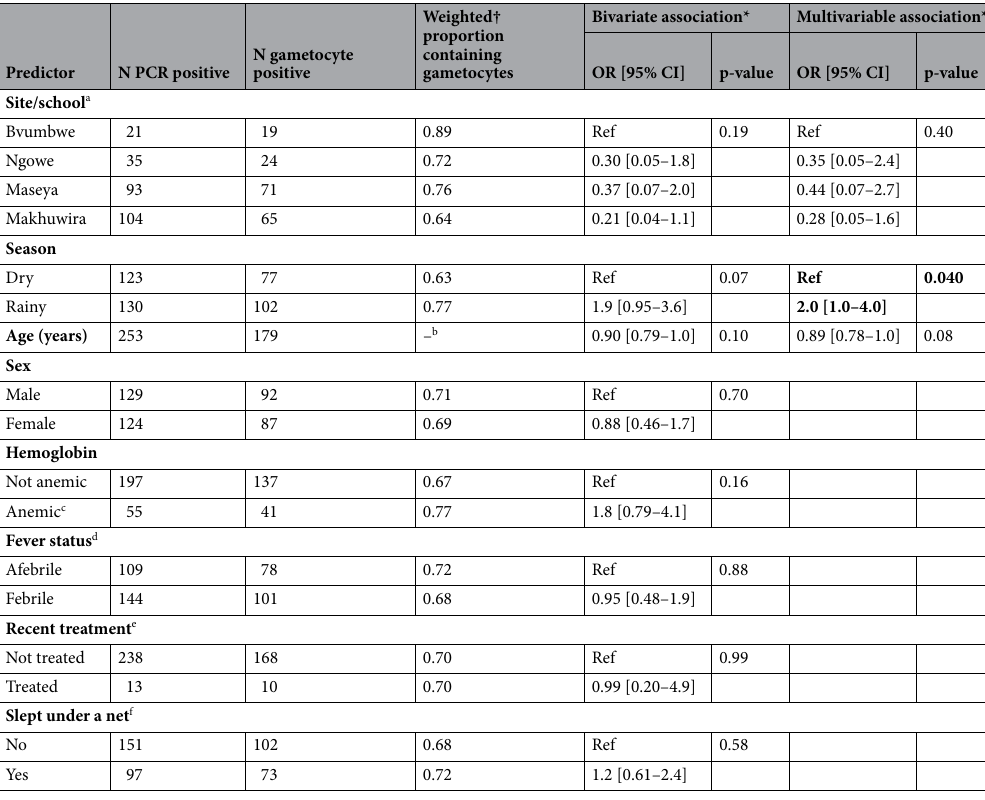
Table 1. Baseline prevalence and predictors of infections containing gametocytes among students with P. falciparum infections in the school-based cohort. † Survey weights were calculated for each stratum, defined as each grade within each school (details in Supplemental Information). * Obtained in a survey weighted logistic regression that analyzed the variables shown in the table. OR = Odds Ratio; CI = Confidence Interval. Bold values are statistically significant for p-values < 0.05. a Univariate association for school, all other associations include school. Prevalence setting: Bvumbwe-low, seasonal; Ngowe-moderate, seasonal; Maseya-high; Makhuwira-high. b Mean age of students with infections containing gametocytes was 10.9 years compared to 11.6 years among those whose infections did not contain gametocytes. c Hemoglobin < 11.0 g/dL; 1 missing observation. d Measured temperature ≥ 37.5 °C at visit or reported in the last two weeks. e Reported in the last two weeks; 2 missing observations. f 5 missing